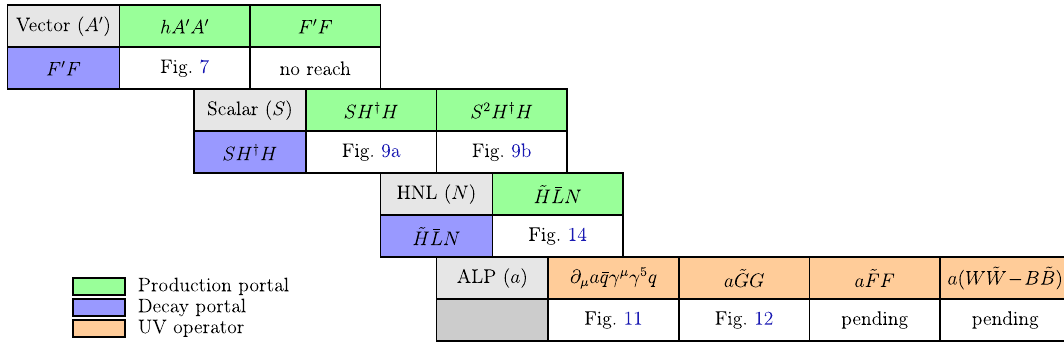
Fig. 6 Minimal model tabular space formed from either: production (green) and decay (blue) portals, where well-defined by symmetries or suppressions; or, UV operators (orange), where either the production and decay portal may involve linear combinations of operators under RG evolution or field redefinitions. Each table cell corresponds to a Fig. 7 Reach for h → A (cid:3) A (cid:3) , as computed in Ref. [8]. Shaded bands refer to the optimistic and conservative estimates of the ATLAS sensitivity [46,47] for 3ab − 1 , as explained in the text. The horizontal dashed line represents the estimated HL-LHC limit on the invisible branching fraction of the Higgs [48]. The MATHUSLA reach is shown for its 200 m × 200 m configuration with 3 ab − 1 ; for AL3X 100 fb − 1 of integrated luminosity was assumed 36 . 1 fb − 1 / 3000 fb − 1 . For the conservative 2DV